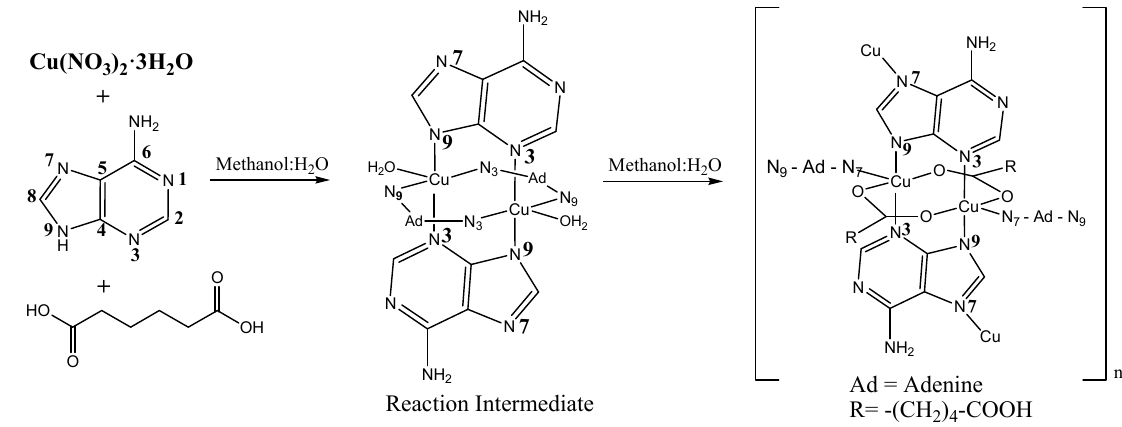
Figure 1. Synthesis scheme of {[Cu 2 ( µ 3 -adeninato) 2 ( µ -Hadip) 2 ]} n ( 1m ) through the intermediate [Cu 2 ( µ -N3,N9-adeninato) 4 (H 2 O) 2 ].